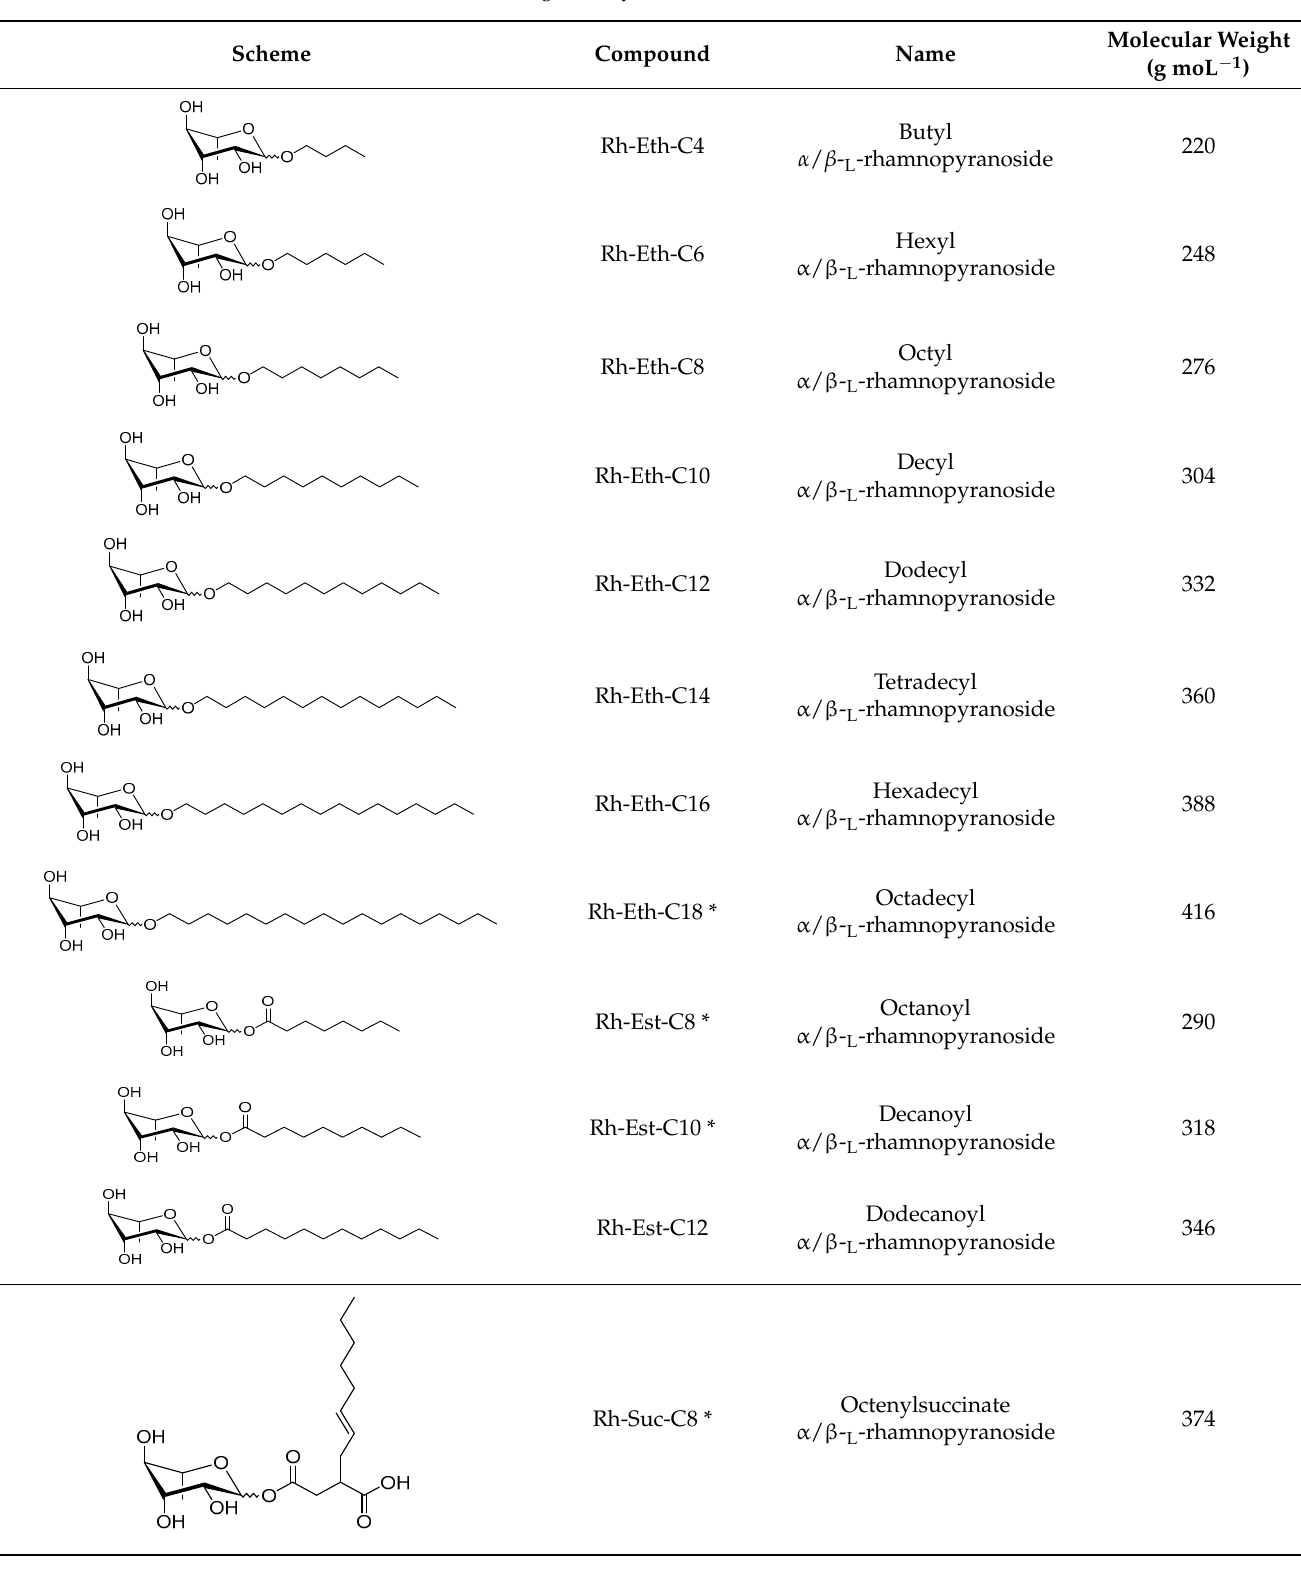
Table 1. List, structure and characteristics of the eighteen synthesized RLs as well as lauric acid, dodecanol and natural RLs.